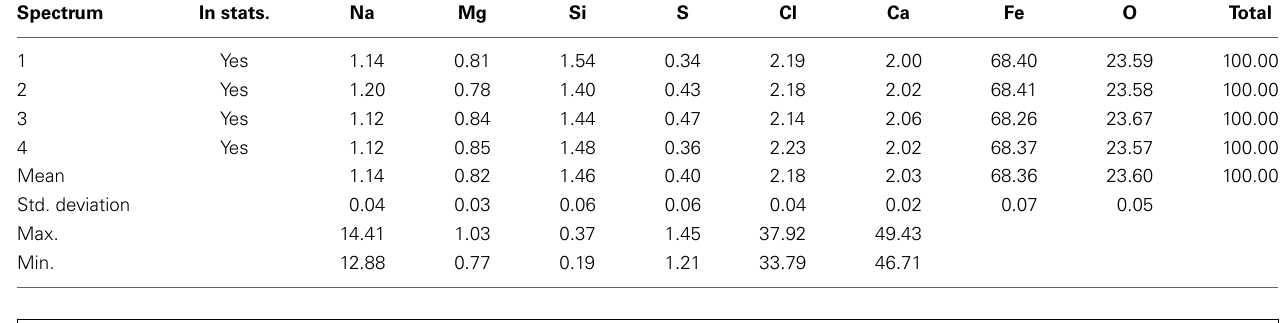
Table 5 | Results of EDX-SEM analyses for the ochre sample treated with SD. Spectrum